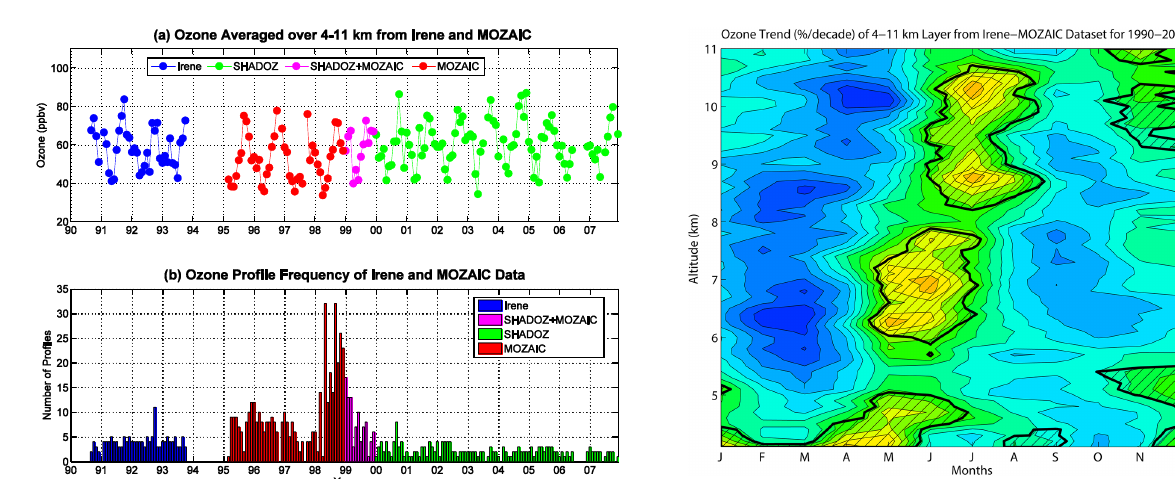
Figure 6. (a) Ozone mixing ratio averaged 4–11km, from the ear- lier (1990–1993) Irene record (blue) and the SHADOZ Irene period (1999–2007) (green). The red dots depict averaged ozone mixing ra- tio, 4–11km, from MOZAIC profiles acquired in 1995–1998 from an instrumented commercial jet during landings and takeoffs at Jo- hannesburg (JNB, O. R. Tambo) airport (Thouret et al., 1998; Clain et al., 2009). The magenta dots represent the combined record of MOZAIC and SHADOZ. (b) Corresponding data frequency of pro- files used in (a) by month for Irene and JNB. Equipment changes by the airlines have interrupted the commercial aircraft ozone sam- pling project in MOZAIC (now IAGOS). Two field campaigns (SAFARI-92/TRACE-A in September–October 1992; Diab et al., 1996; Thompson et al., 1996) and SAFARI-2000 in September 2000 (Swap et al., 2003; Thompson et al., 2002) gave rise to more fre- quent Irene launches.